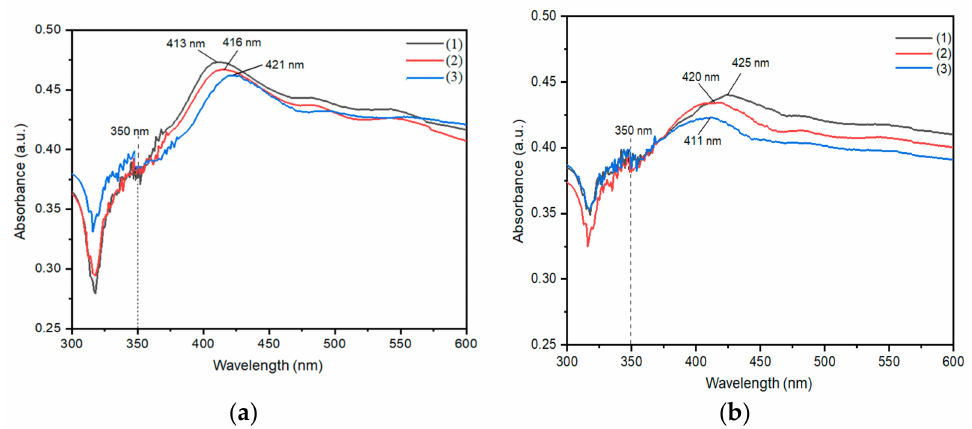
Figure 1. UV-Vis spectrum of AgNWs samples: ( a ) before being vibrated and ( b ) after being vibrated by (1) water medium, (2) ice medium, and (3) dry ice